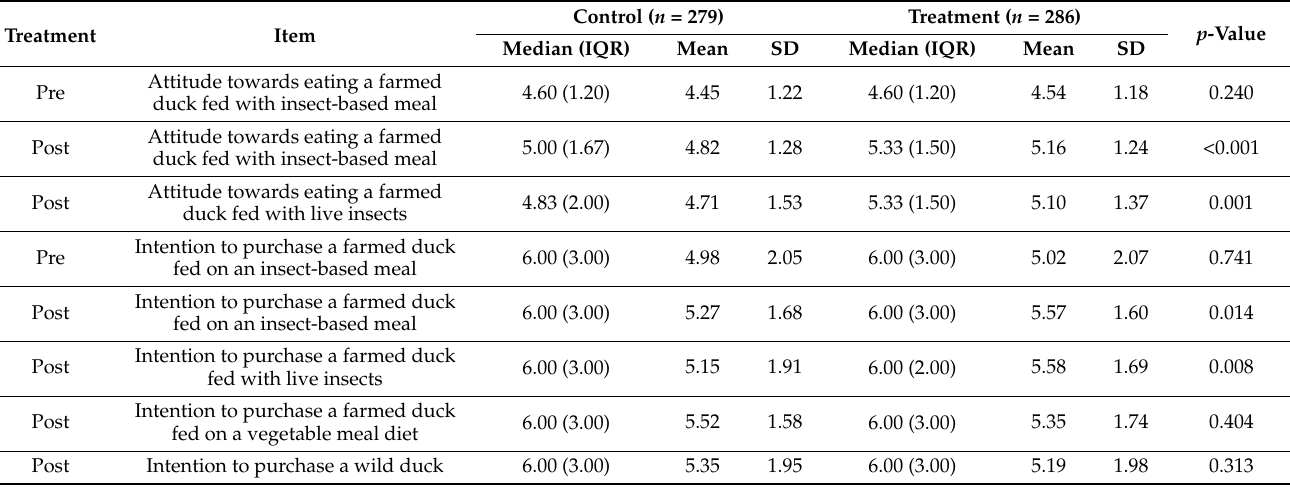
Table 2. Attitude towards and intention to purchase a farmed duck fed via different feeding methods (median, IQR: interquartile range; mean, SD: standard deviation; p -value for non-parametric Mann–Whitney test for independent samples).